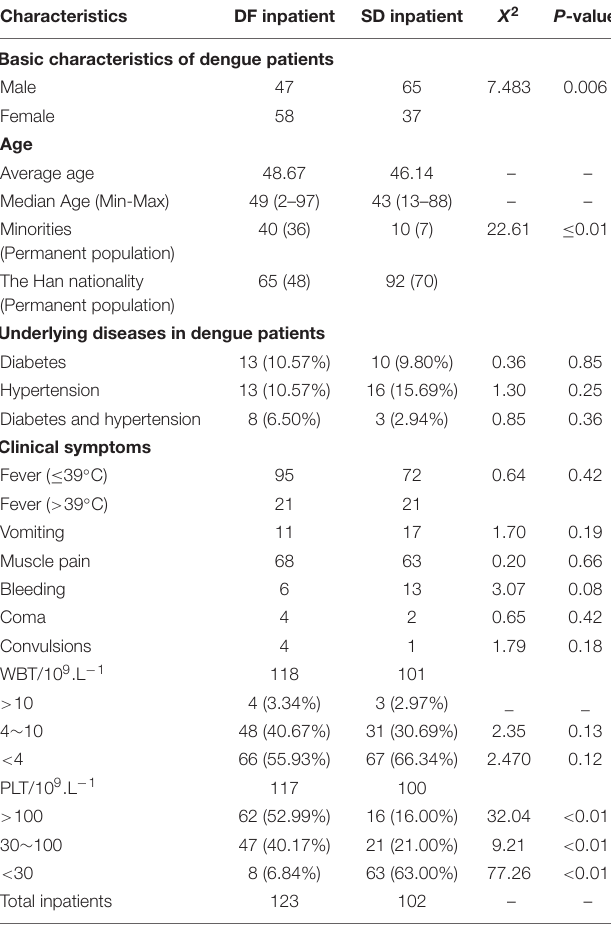
TABLE 1 | Comparison of characteristics of moderate and severe dengue fever